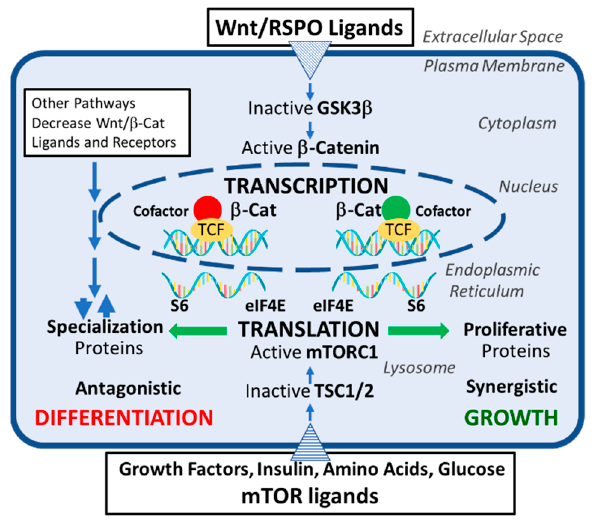
Figure 3. Simplified cartoon of potential crosstalk between activated canonical Wnt/ β -catenin and mTORC1 pathways. Wnt ligand activation of Frizzled (FZD) plasma membrane receptors results in phosphorylation and inactivation of glycogen synthase kinase-3 beta (GSK3 β ), which can no longer phosphorylate β -catenin for destruction. β -catenin accumulates in the cytoplasm and translocates to the nucleus, where it binds with T cell factor (TCF) transcription factors and other cell-specific cofactors. The relative amount of differentiated (red circle) vs. growth (green circle) β -catenin-binding cofactors results in transcription of mRNAs for differentiation or proliferative proteins. Other signaling pathways, such as the mitogen-activated protein (MAP) kinase pathway, may alter Wnt/ β -catenin/mTORC1 crosstalk.